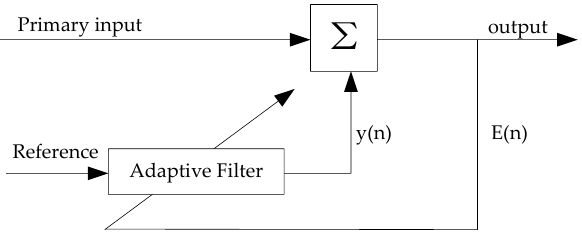
Figure 3. Functional diagram of an adaptive filter system.